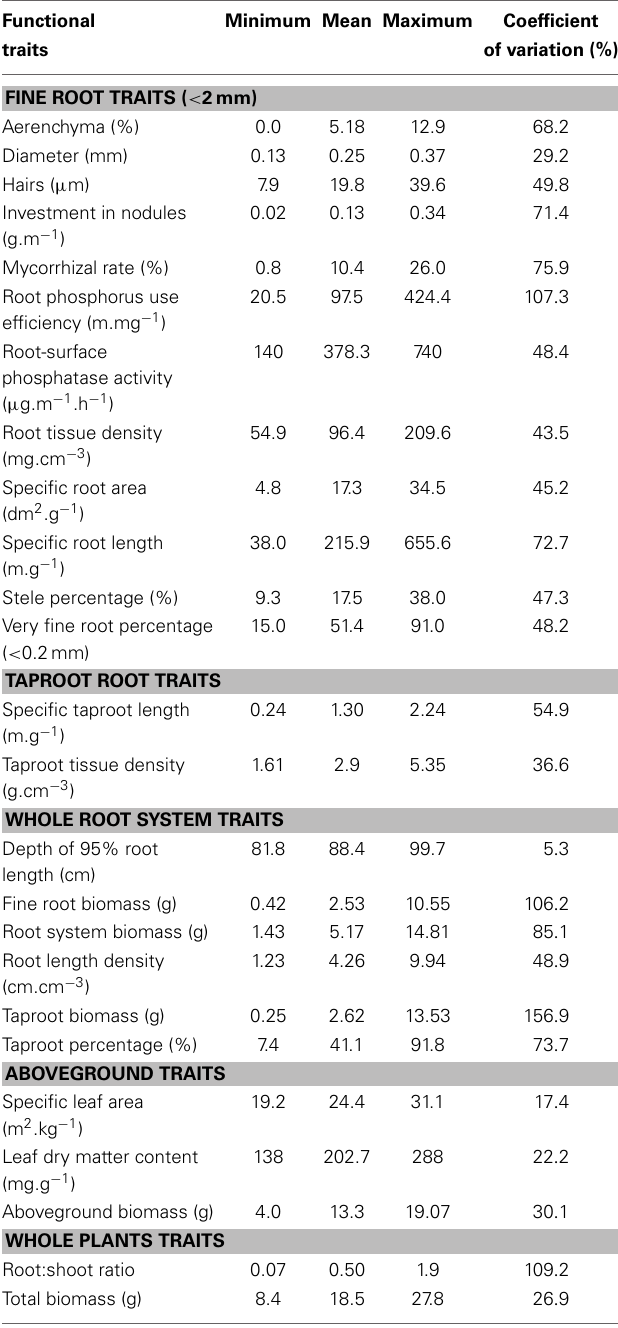
Table 2 | Functional trait minimum, mean, maximum and coefficient of variation values of 13 Fabaceae species ( n = 13).